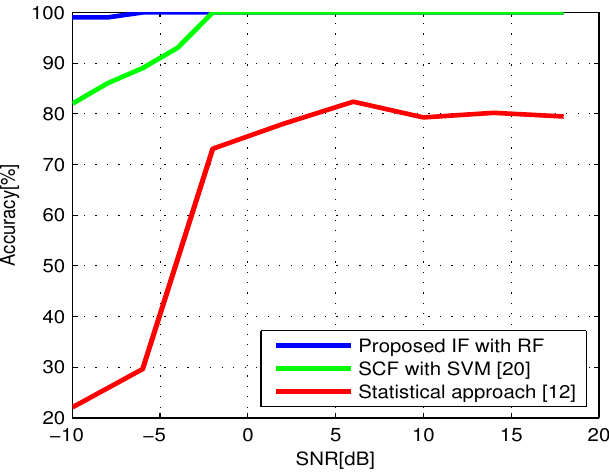
Figure 5. Classification accuracy with respect to